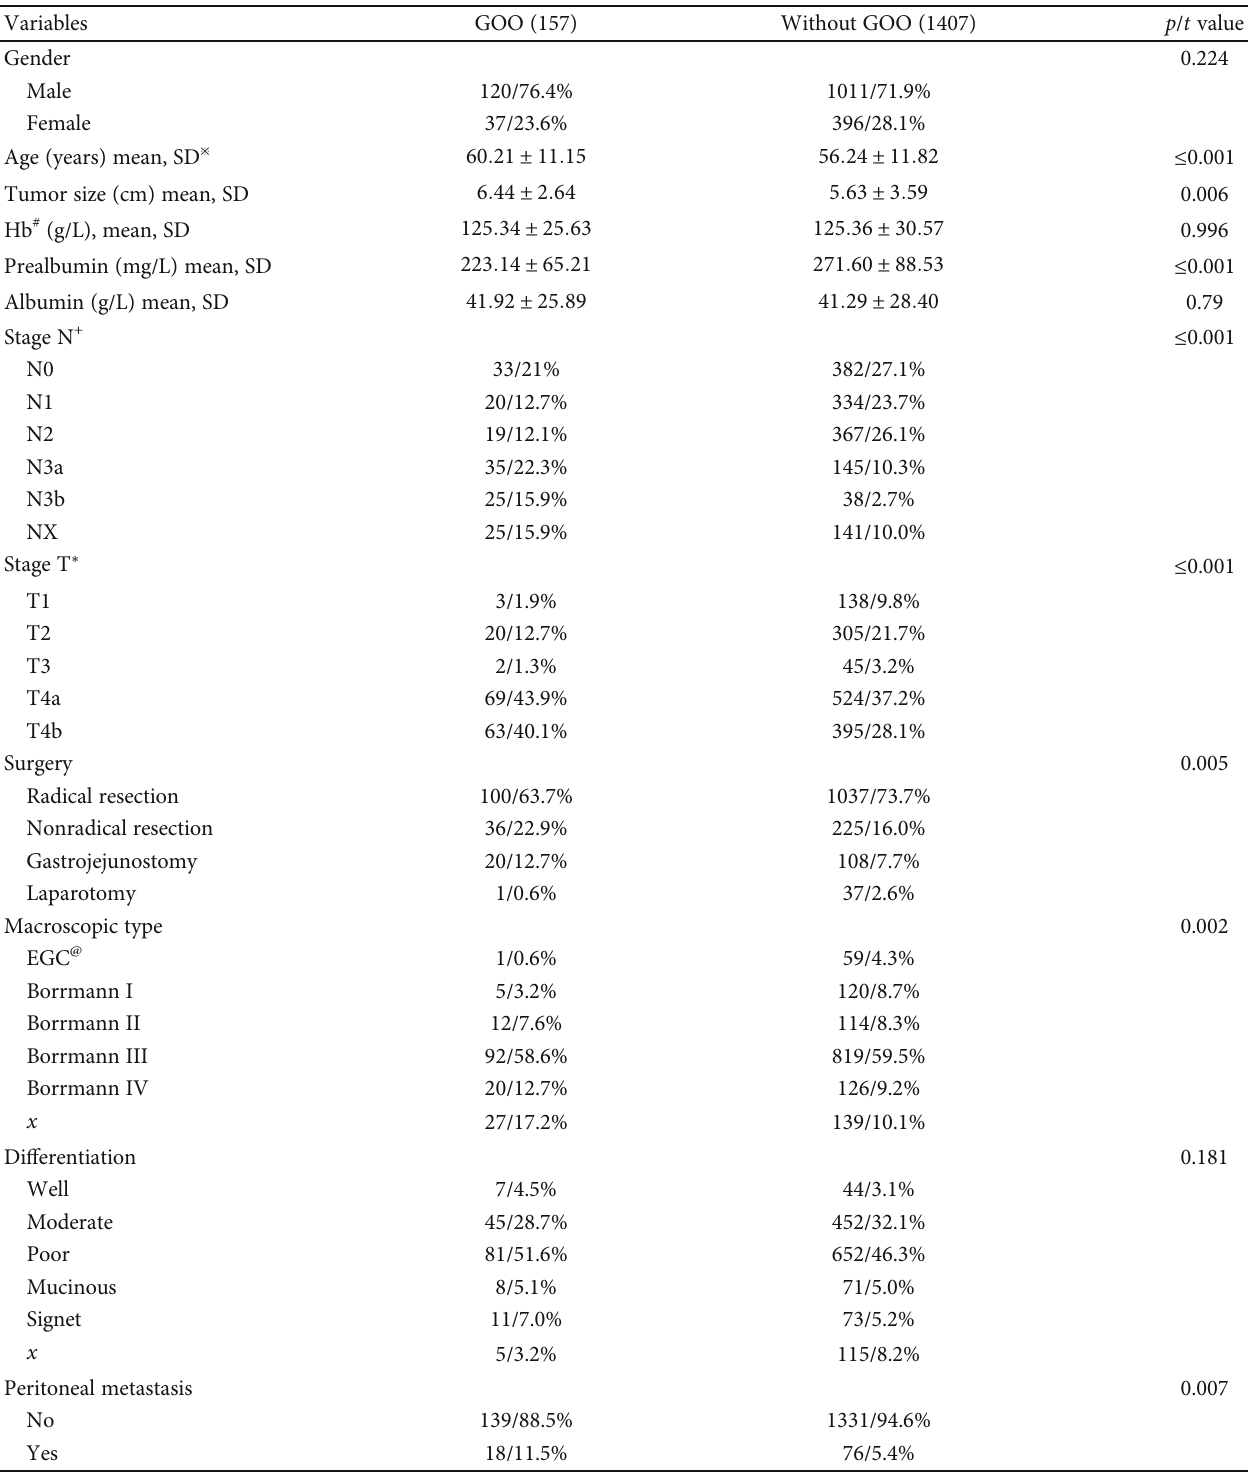
Table 1: Clinicopathological features and treatment-related factors of the patients with and without GOO groups.